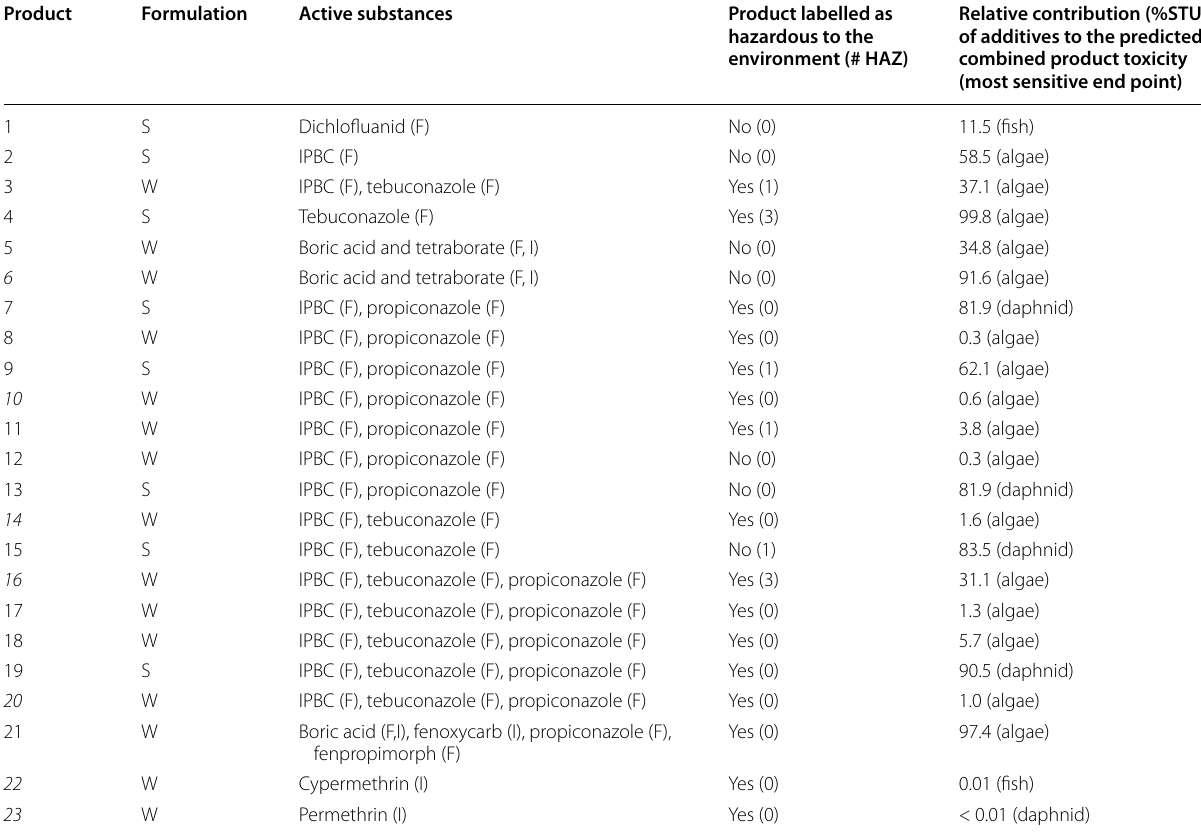
For products 1–21, mixture toxicity predictions are based on all compounds including confidential additives for which data were available, while for products 22 and 23 predictions relate only to the a.s. and the additives identified in the product safety data sheets. Products indicated in italics were selected for the